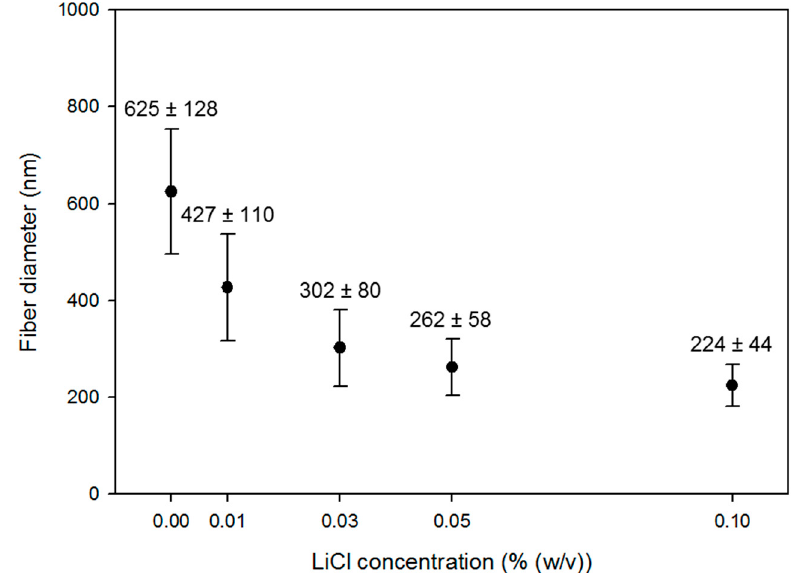
Figure 4. The LiCl concentration effects on the average diameter of 30% (w/v) PES nanofibers at each optimal voltage, the feed rate of 0.5 mL/h, and the tip-to-collector distance of 20